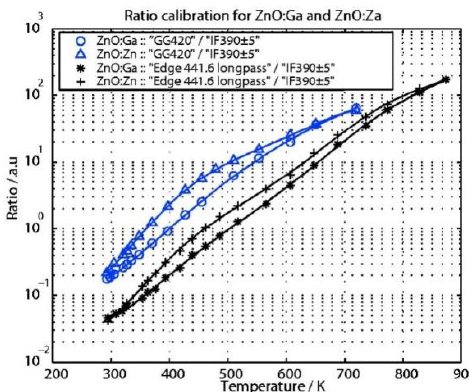
Figure 23. Characteristic spectral ratio calibration of ZnO:Zn and ZnO:Ga with two different long- pass filter sets [96]. Reprinted with permission from [96]. Optica Publishing Group, 2008.